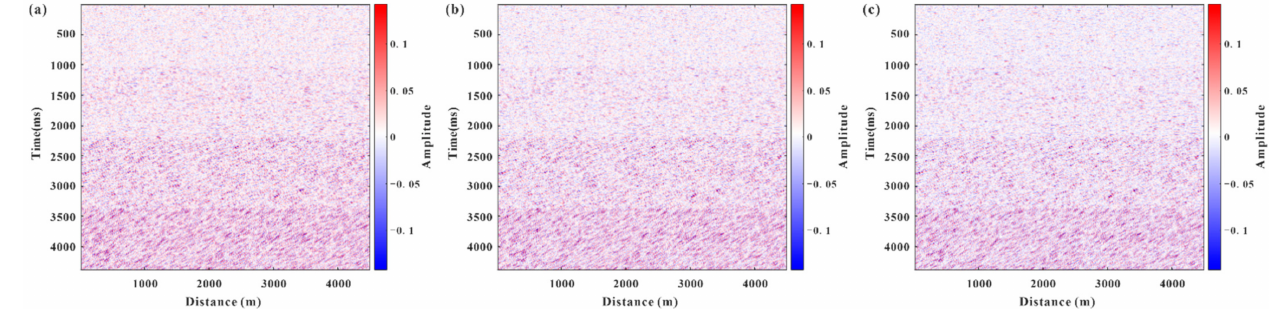
Figure 7. Noise-containing synthetic seismic data from different center angles: ( a ) 7 ◦ , ( b ) 18 ◦ , ( c ) 26 ◦